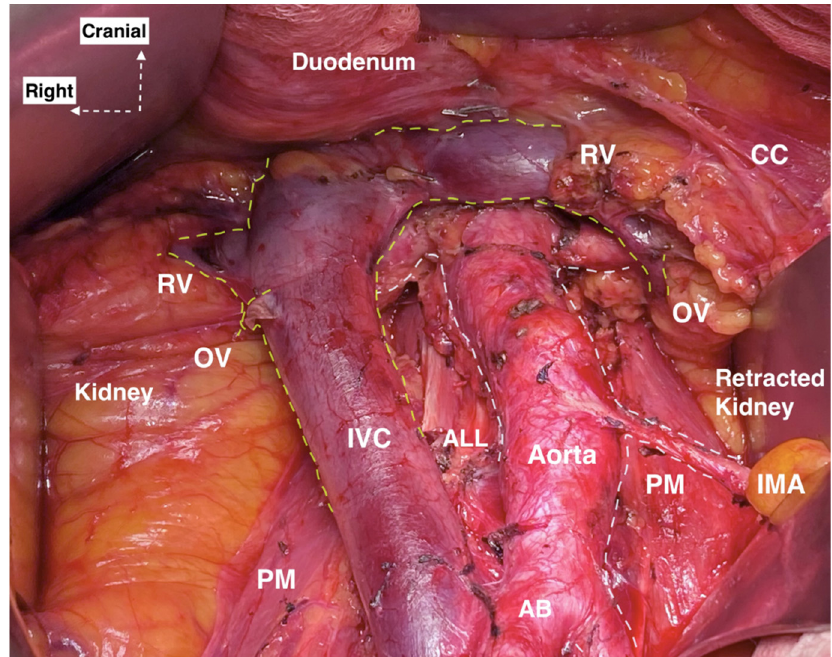
Figure 7. Right and left renal artery lying below the right and left renal vein (open surgery per- formed by doctor Ilker Selcuk). RV—renal vein, OV—ovarian vein, IVC—inferior vena